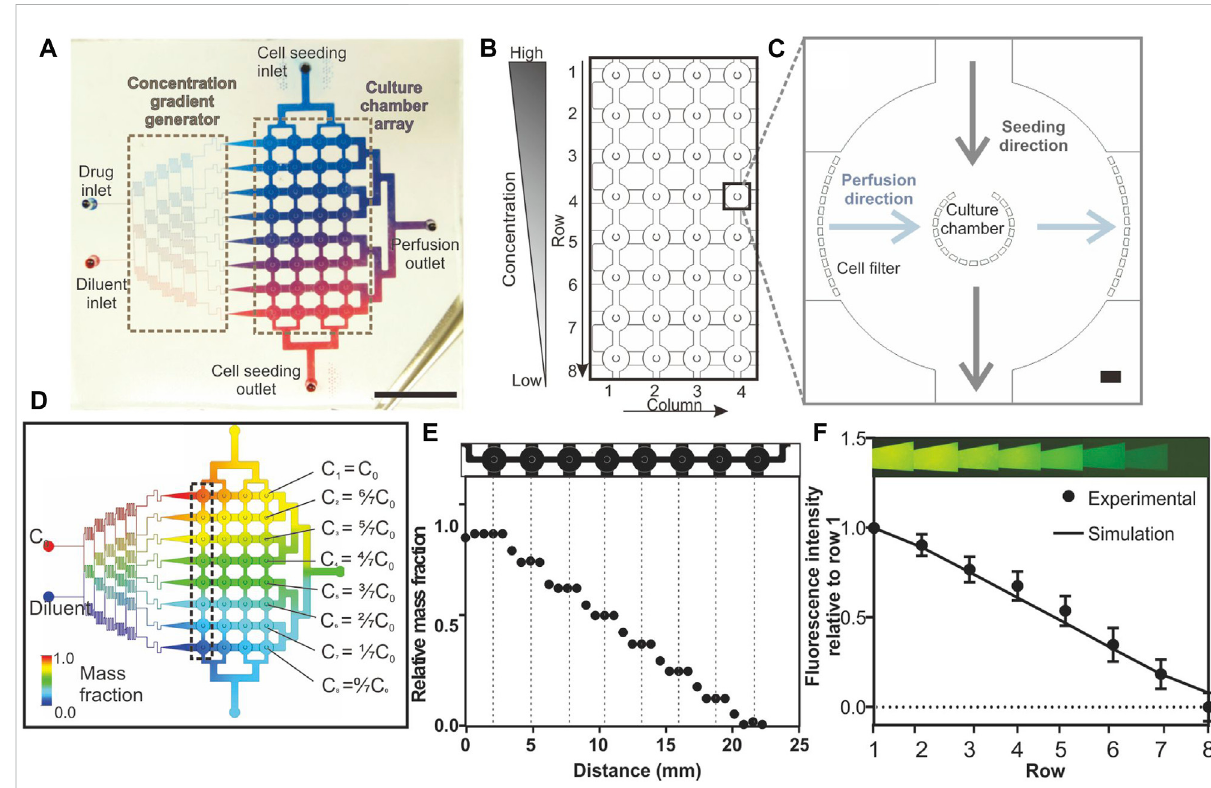
FIGURE 1 Design and characterisation of the Integrated Micro fl uidic Tumour Array (IMITA) device for multiplexed 3D cell cultures. (A) The IMITA device consisted of two functional blocks (Lin et al., 2017): concentration gradient generator; and (Wei et al., 2017) cell culture array connected by two orthogonal fl ow circuits for cell seeding and medium perfusion. Scale bar = 1 cm. (B) The cell culture array consisted of 32 cell culture chambers arranged in8 rows by 4columns. (C) Each cell culture chamber compriseda cup-shaped micropillar arraywith 20 µmgaps where theopening facedtheseeding fl owcircuittotraptheincomingcells.Aseriesofmicropillarsactascell fi ltersalongthemediumperfusiondirectiontopreventcell cloggingduringcellseeding.Scalebar=100 µm. (D) CFDsimulationshowing8massconcentrationsgeneratedbyalinearconcentrationgenerator, which werefed into each row of theIMITA device atsteady state when operating at0.02 ml h − 1 . (E) Simulatedrelative massfractionsas a function of distancealongasinglerowofcellculturechamber[boxindicatedin1(d)]atsteadystateoperatingcondition.Massfractionwithinasinglecellculture chamber remained constant while a linear decrease was observed across each chamber in a row. (F) Experimental validation of the concentration gradient generator using rhodamine fl uorescent probe. Data are averages of 3 experiment measurements ± standard